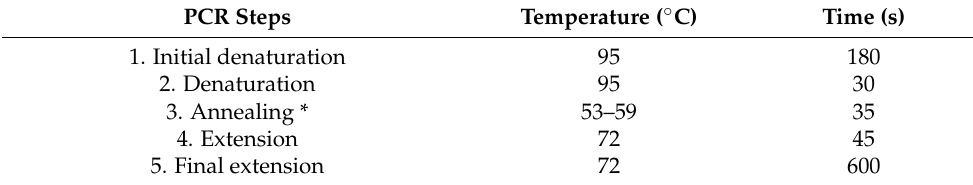
Table 3. PCR condition for different gene.